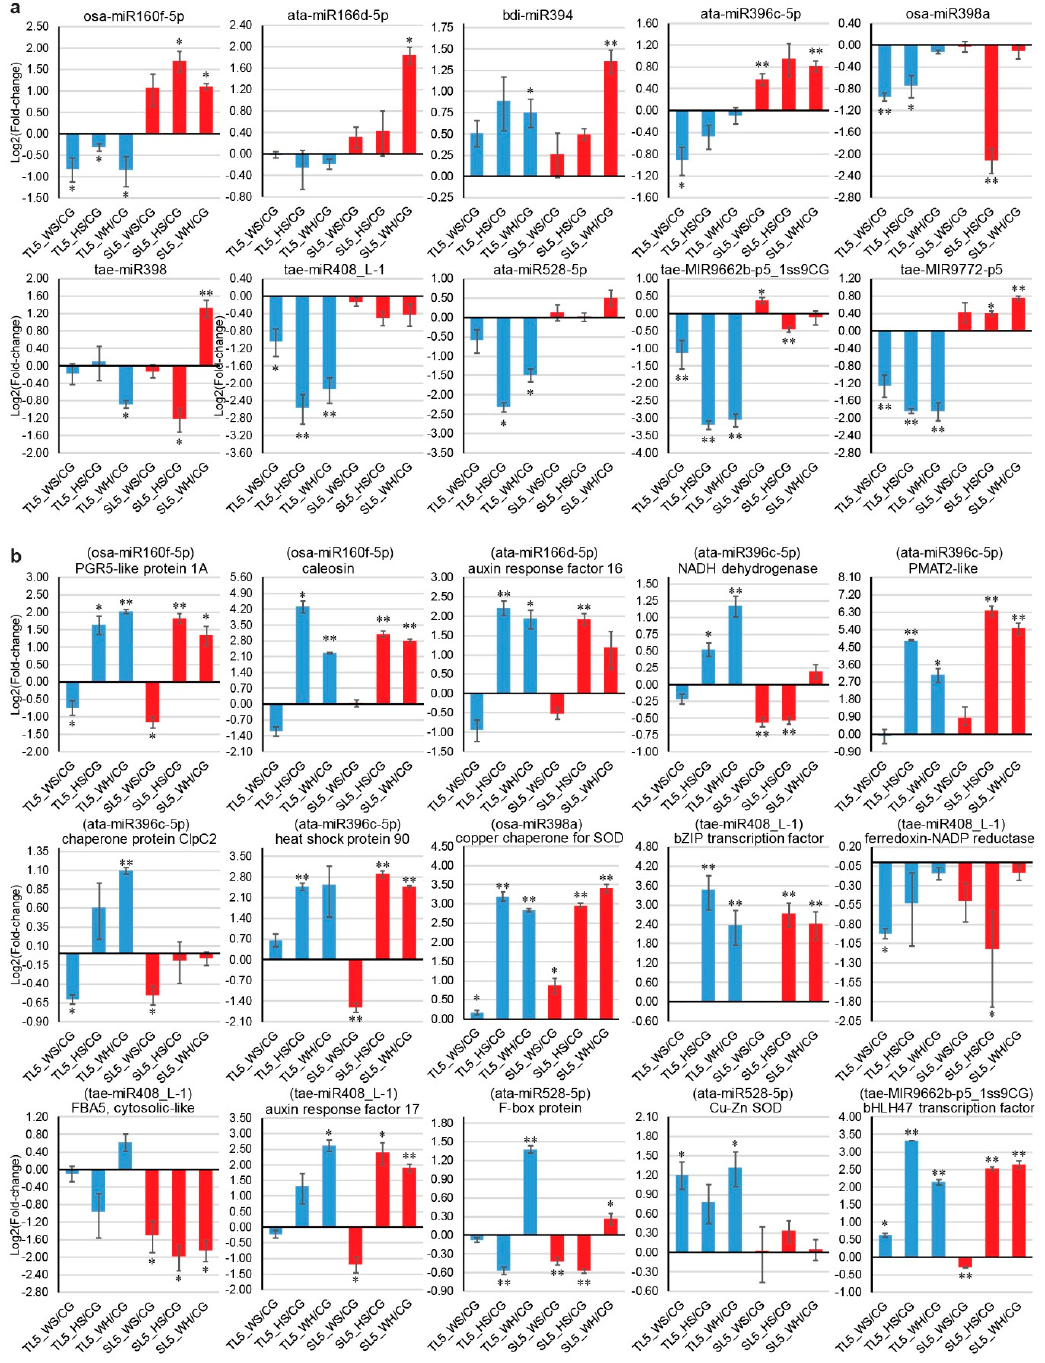
Figure 5. qPCR analysis of ten stress-responsive miRNAs and 15 target genes at 5 DPA (days post-anthesis). ( a ) Expression profiles of miRNAs. ( b ) Expression profiles of target genes. Each expression